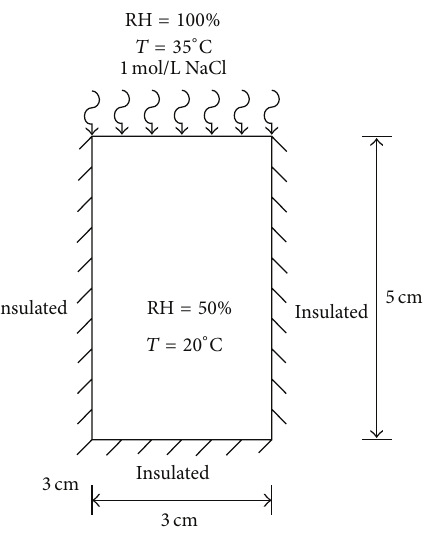
Figure 1: Concrete sample used in the numerical simulation. Table 2: Material parameters and input data for simulated concrete